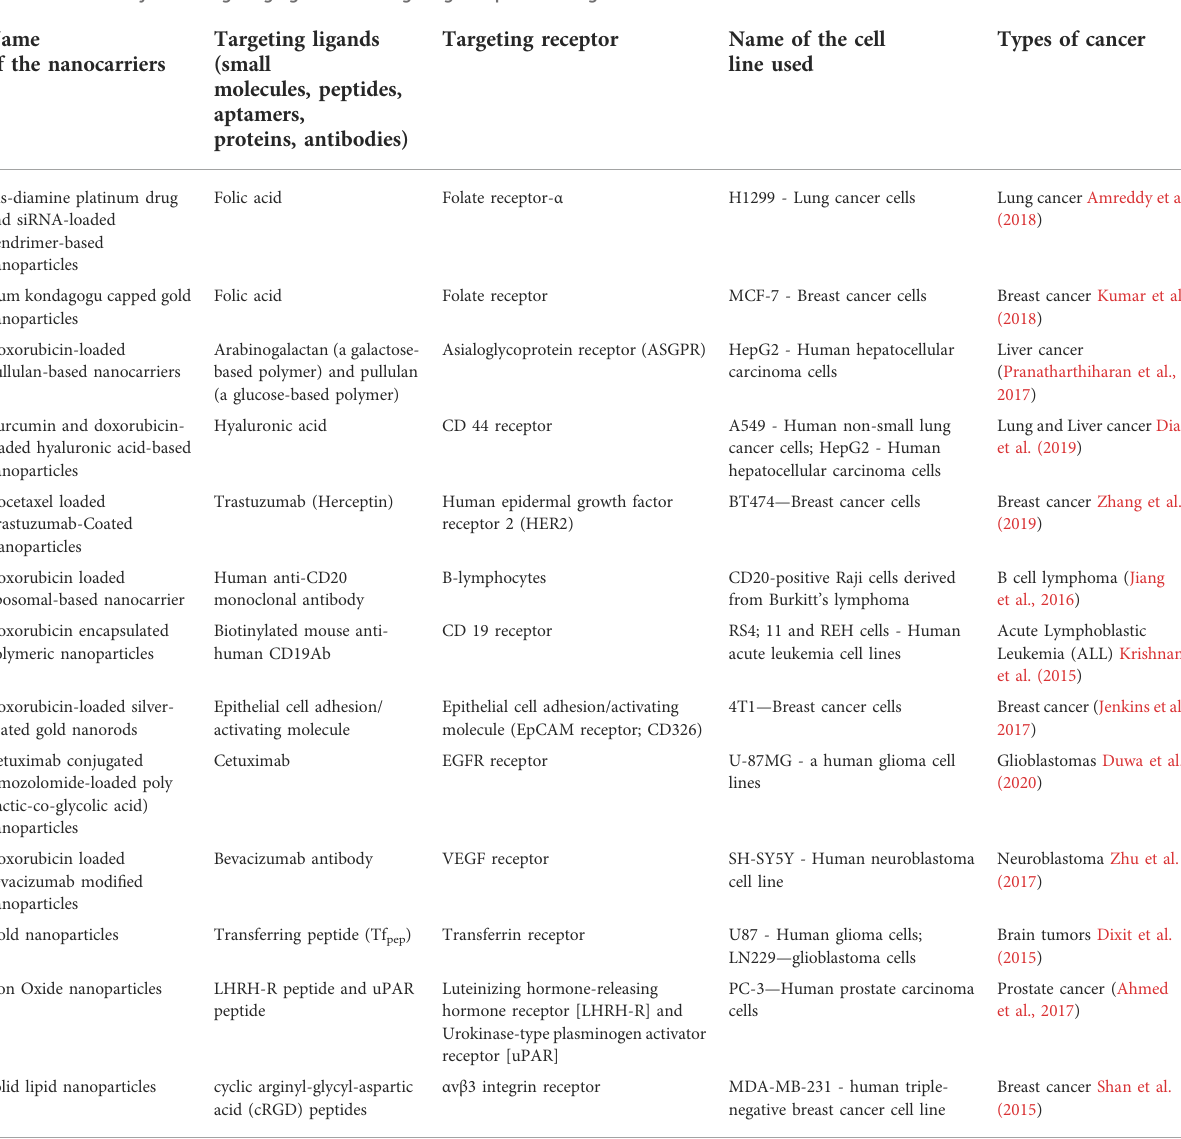
TABLE 2 Commonly used targeting ligands and targeting receptor for targeted cancer